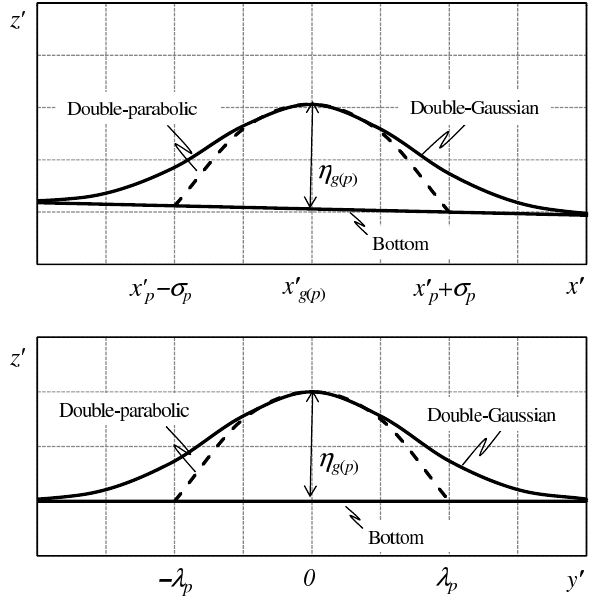
Fig. 2. Vertical cross sections of the double Gaussian landslide (solid line) and the double parabolic slide (dashed lines) in physical variables in the (x 0 ,z 0 ) plane (upper panel) and in the (y 0 ,z 0 ) plane (lower panel). Here σ g = σ p , η g = η p and vertical dimensions are exaggerated for easiness of reading.